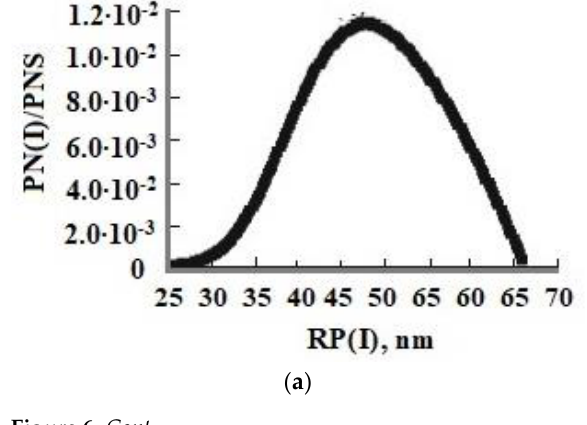
( b ) ( c ) Figure 6. The particle size distribution at different pH and initial OSA concentrations C s . ( a ) T = 50 °C, C s = 700 mg/kg, рН = 4 ; ( b ) T = 50 °C, C s = 700 mg/kg, рН = 8 ; ( c ) T = 60 °C, C s = 800 mg/kg, pH = 8. PNS — total quantity of the formed SiO 2 particles. 3.3. Simulation of OSA Polymerization at Different Ionic Strengths The dependence of C s (Tp) is also affected by the ionic strength of the I s solution. The simulation results were obtained at t = 20 °C, pH = 8.0, and C s = 700 mg/kg and various values of I s : 0.014, 0.07, 0.14, 0.28, 0.4, 0.8, 1.0, 1.2, 1.4, 7.1, 10.6, and 14.2 mol/kg. With an